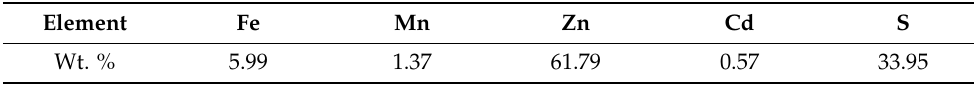
Table 2. Elemental composition of raw natural sphalerite. Element